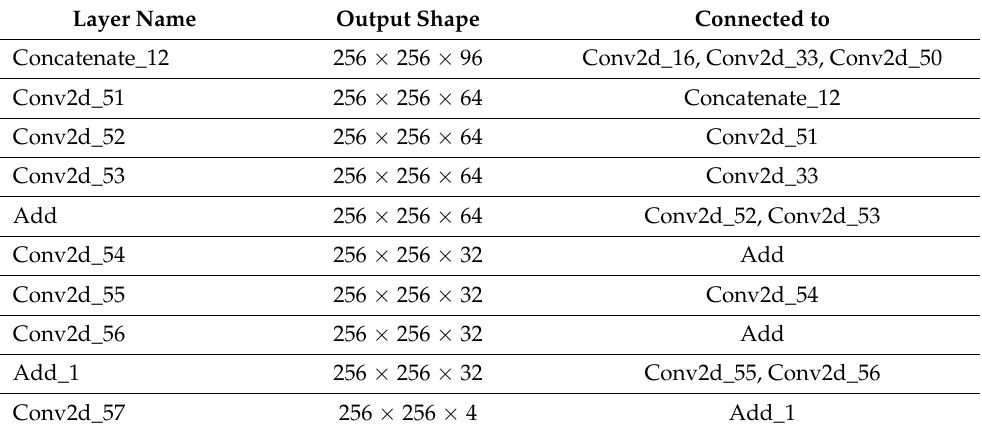
Table 2. Architecture of the proposed residual network for merging the parallel Unets.